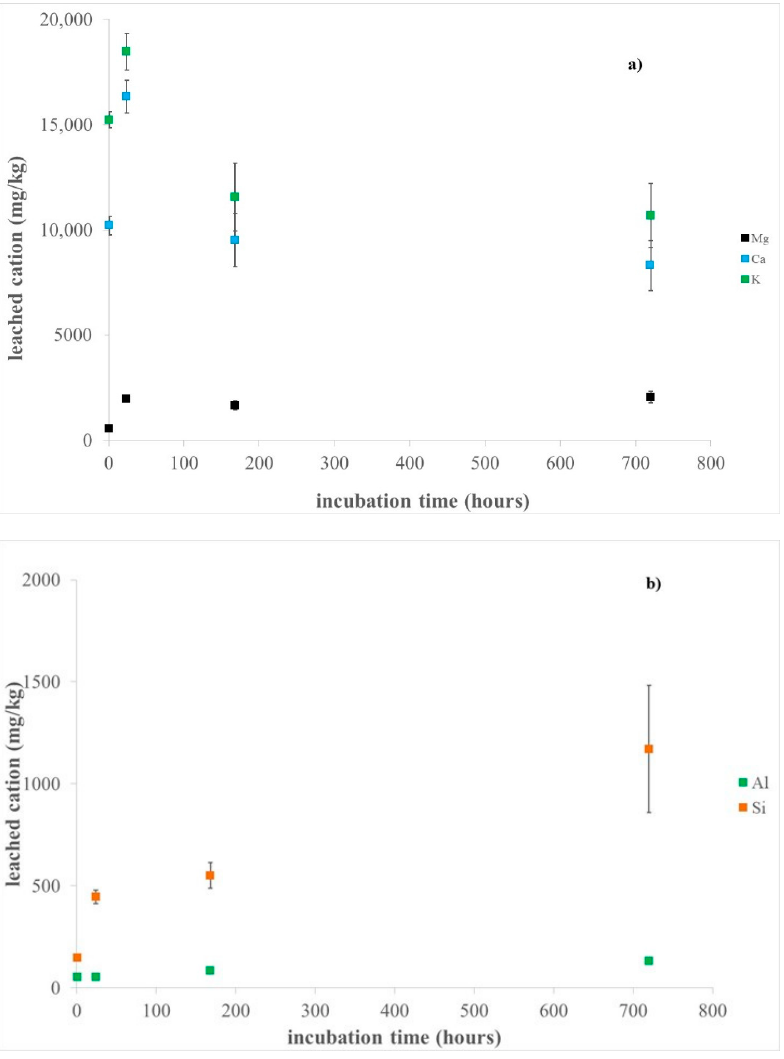
Figure 3. Dissolution of erionite fibres in the MGS solution at pH 4.5 up to 1 month: ( a ) released of K, Ca, and Mg extra-framework cations; ( b ) released Si and Al framework cations.